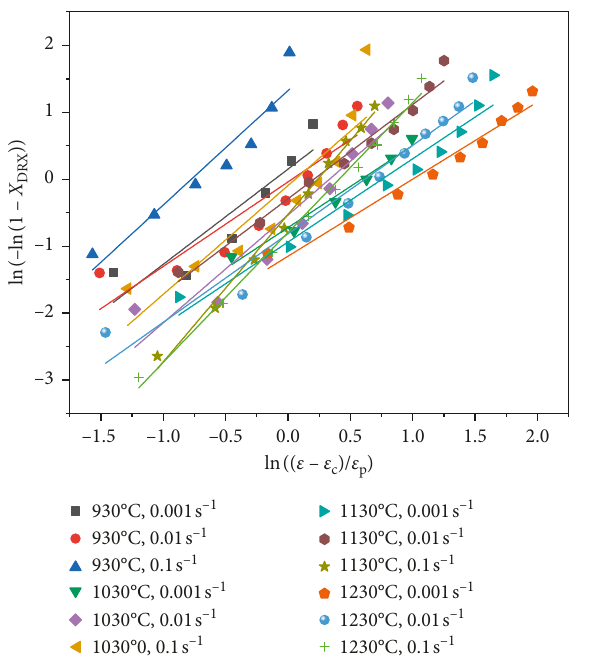
Figure 6: Relationships between ln (− ln ( 1 − X − ε ) / ε ) at different deformation conditions. ln (( ε c p